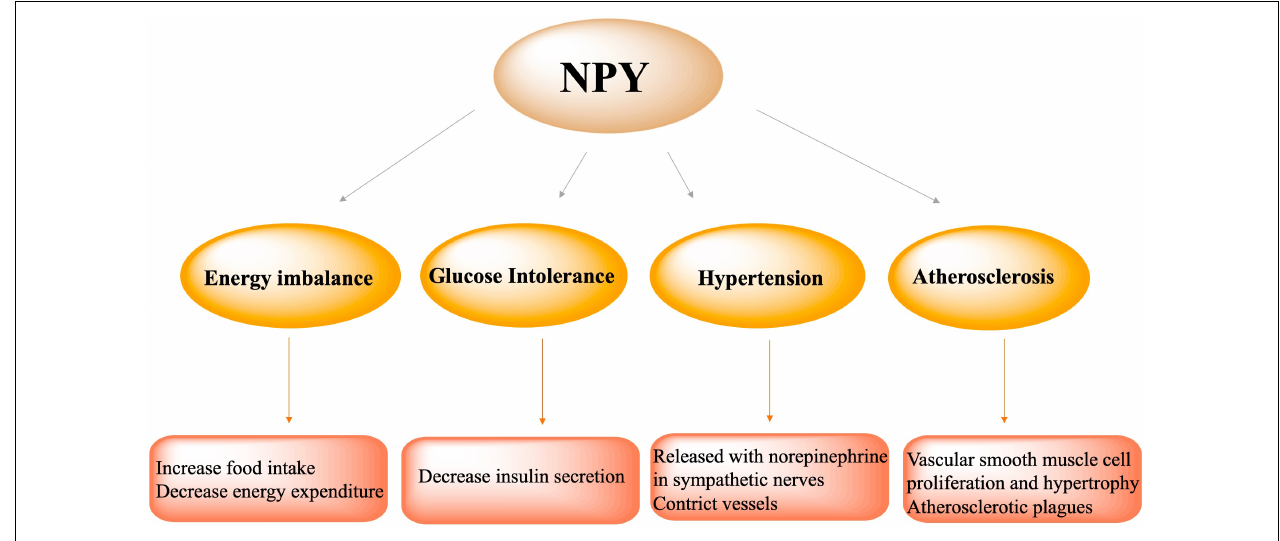
FIGURE 3 | NPY participated in the pathophysiological process of metabolic syndrome, including energy imbalance via increasing food intake and decreasing energy expenditure, glucose intolerance via decreasing insulin secretion, hypertension via NPY release with norepinephrine in sympathetic nerves and vasoconstriction, atherosclerosis via vascular smooth muscle cell proliferation and hypertrophy and formation of atherosclerotic